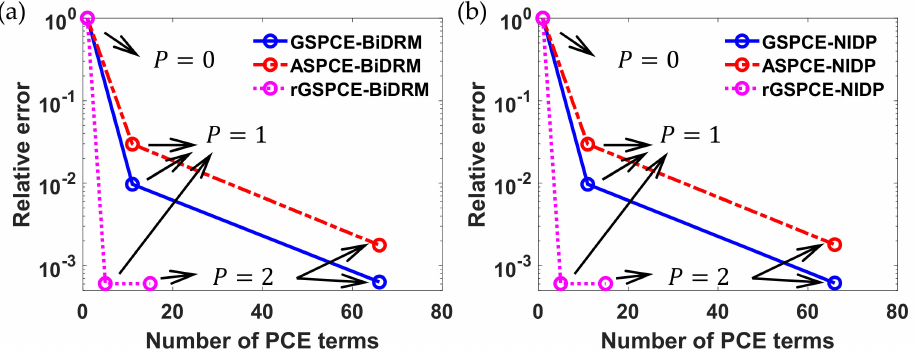
Figure 3. Comparison of the relative error of the variance for Z with different ( a ) bivariate dimension reduction method (BiDRM)- and ( b ) non-intrusive discrete projection (NIDP)-based polynomial chaos expansion (PCE)